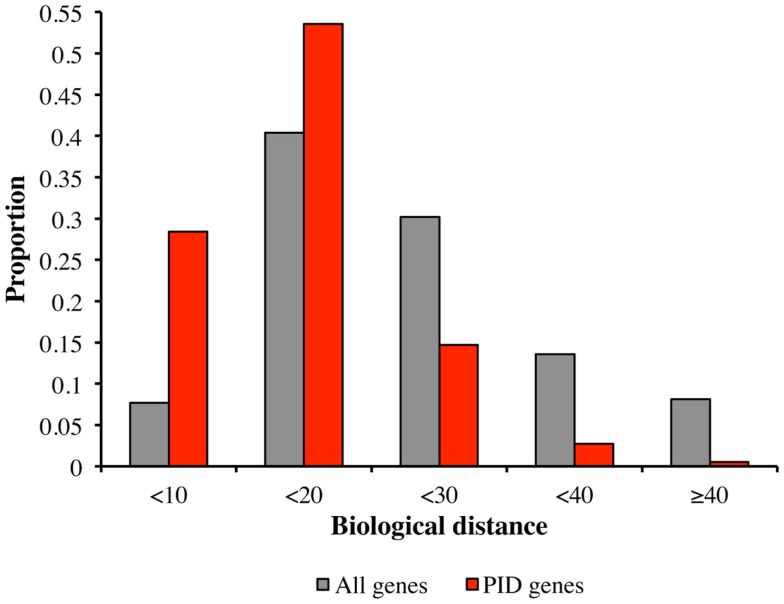
Comparison of biological distances between PID genes and all human genes. Biological distances between PID genes (red) and all human genes (gray), according to the proportion of distances in five categories: (1) small biological distance (<10); (2) small-medium biological distance (between 10 and 20); (3) medium-large biological distance (between 20 and 30); (4) large-very large biological distance (between 30 and 40); and (5) extremely large biological distance (>40).